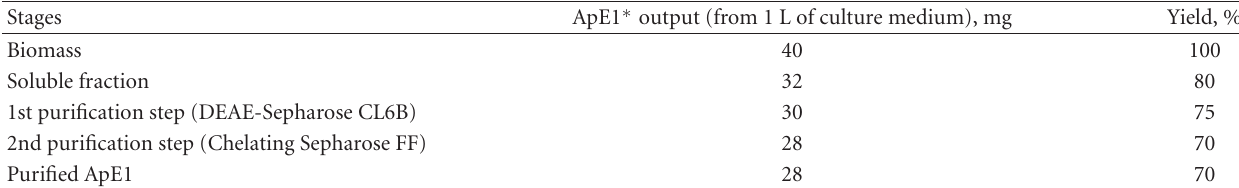
Table 1: Yield of the target protein ApE1 in successive purification stages.